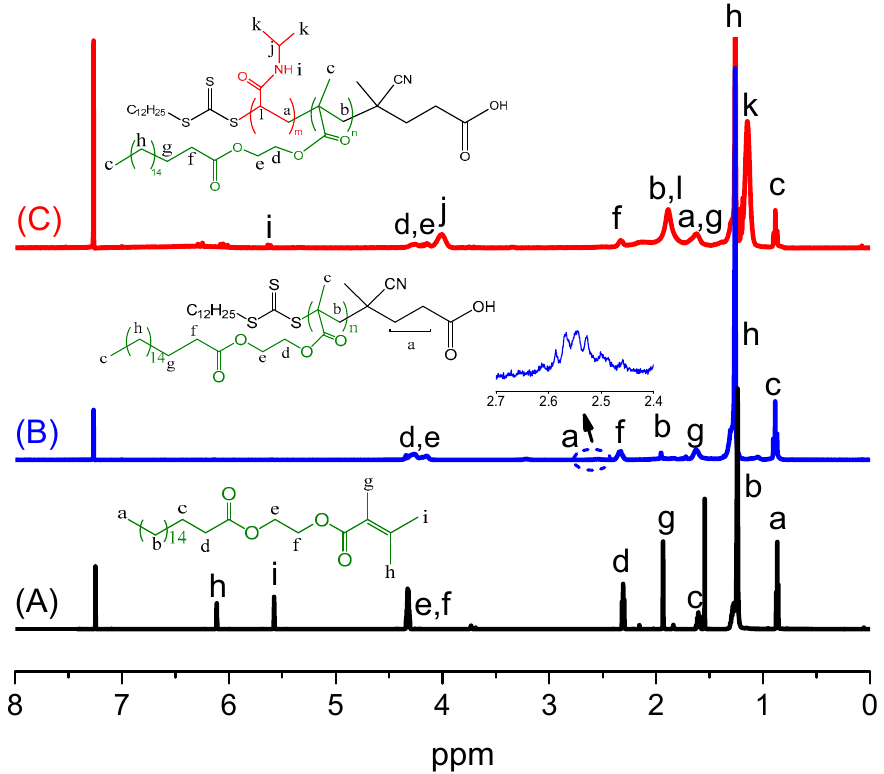
macro-CTA and block copolymerization. The molecular weights measured by GPC matched reasonably well with M n,NMR based on DP, in spite of there being some discrep- ancy with the theoretical molecular weights calculated on the basis of monomer conver- sion by NMR. Note that the molecular weights measured by GPC are relative values with respect to polystyrene standards. Figure 1. 1 H NMR spectrum of ( A ) SAMA, ( B ) PSAMA and ( C ) PSAMA- b -PNIPAM. Starting with PSAMA 8 and PSAMA 12 as macro-CTA, three PSAMA- b -PNIPAM block copolymers with variable block lengths using different molar ratios of monomer to macro- CTA were synthesized, at a fixed ratio of (macro-CTA)/(AIBN) = 0.2. The GPC spectra of homopolymers and block copolymers are shown in Figure 2. GPC curves of PSAMA- b - PNIPAM moved towards the higher molecular weight region in contrast to PSAMA macro-CTA while maintaining low PDI (<1.2). The GPC peaks were all unimodal and symmetric without any bimolecular termination products or unreacted macro-CTA.